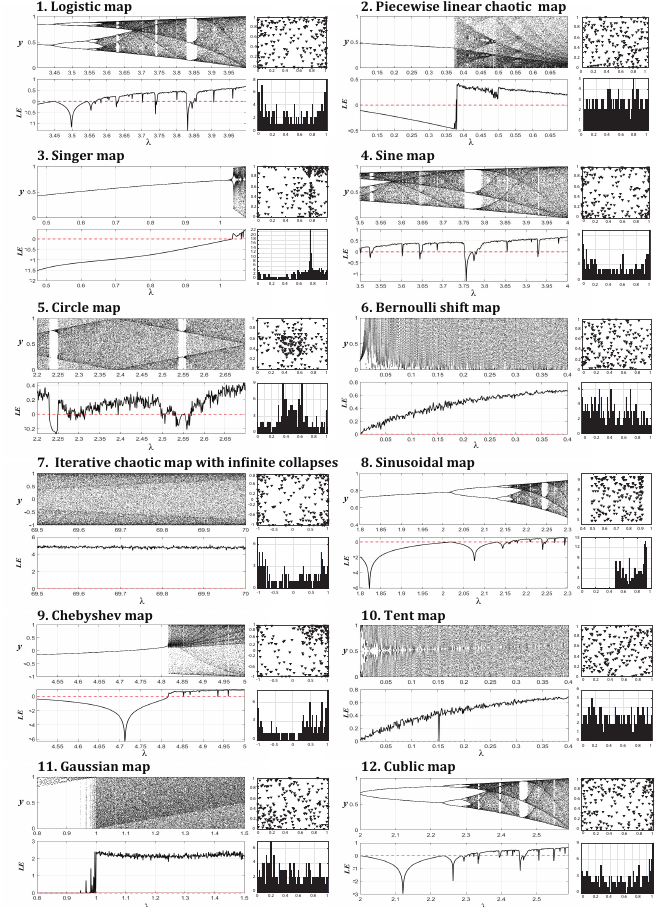
Figure 1. Twelve common chaotic